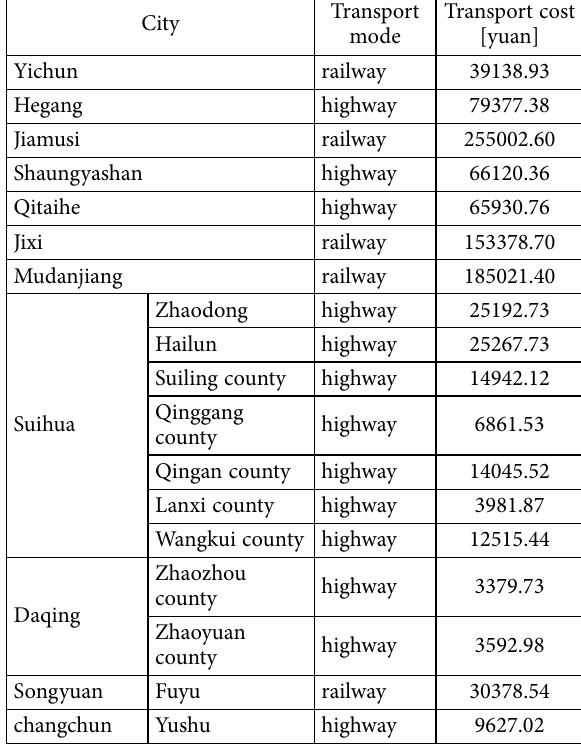
Table 7. Transport modes and costs of railway container terminal of each city in attraction